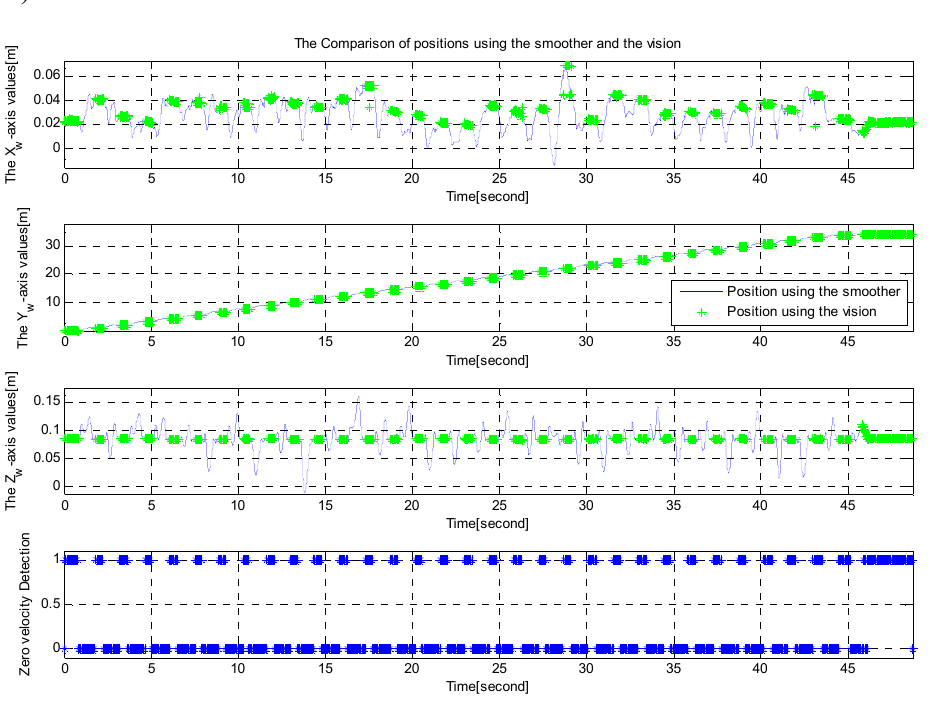
Figure 11. Floor experiment (Comparison of smoother estimated and vision estimated positions).